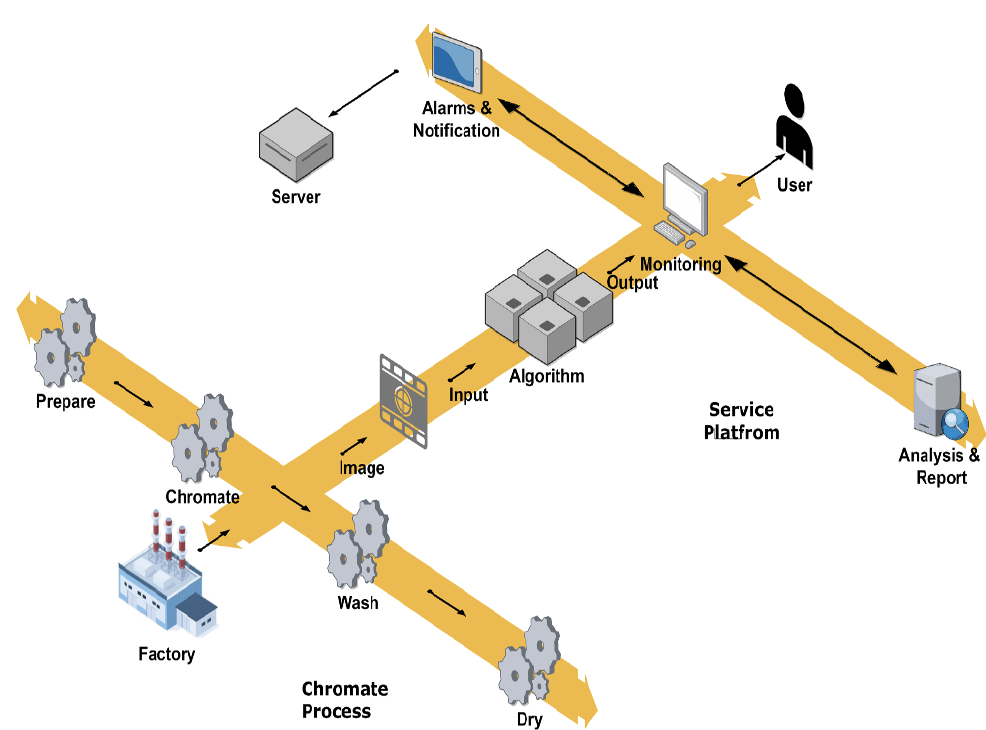
Figure 5. System architecture for chromate